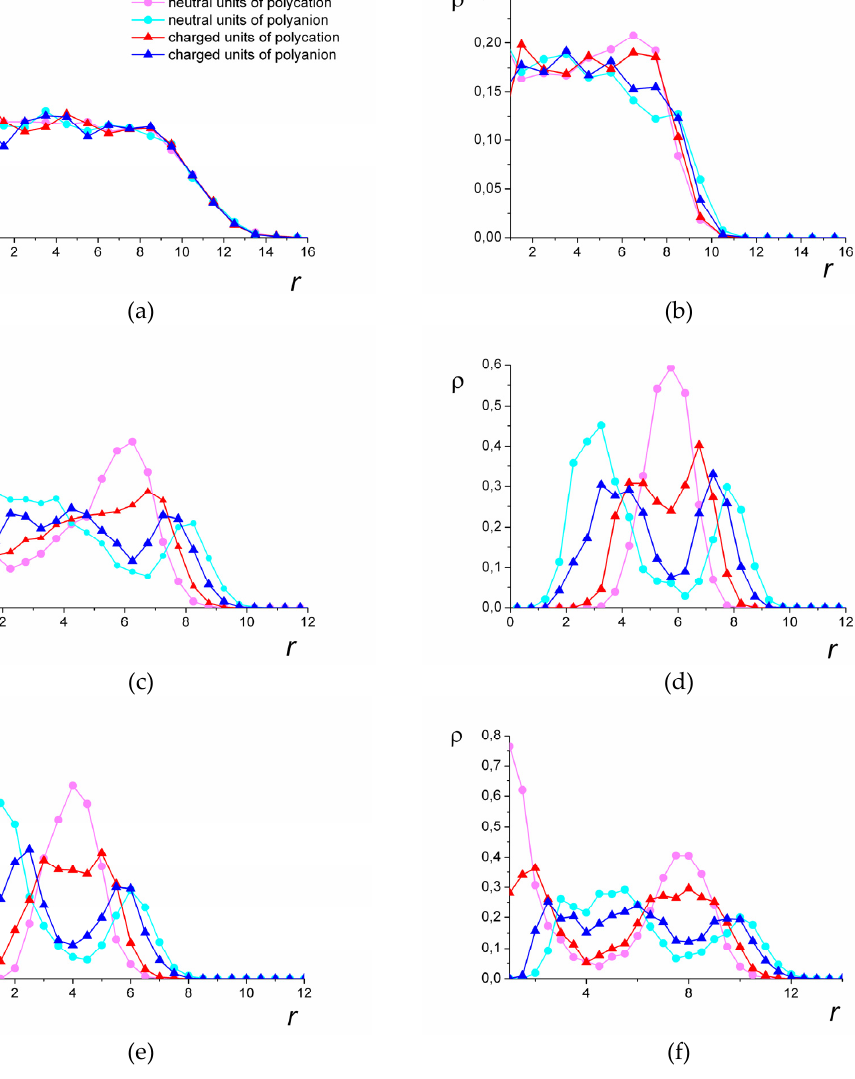
Figure 5. The spatial distribution of the groups: N = 1024, l B = 6, ε HH = − 1.5 ( c ), ε HH = − 1.8 ( d ), N = 512, l B = 6, ε HH = − 1.4 ( e ), N = 2048, l B = 4, ε HH = − 1.5 ( f ). r